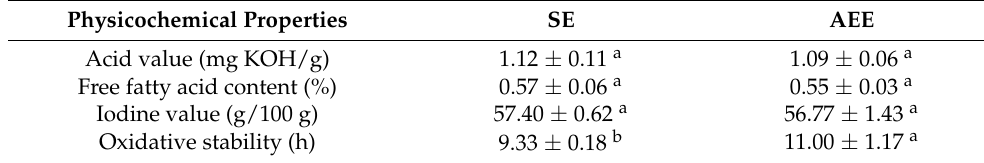
Table 3. Physicochemical properties of OMSS obtained by solvent extraction (SE), and aqueous enzymatic extraction (AEE).